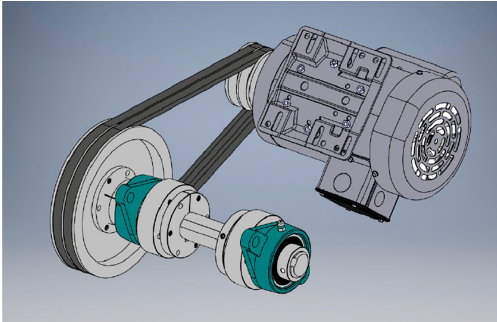
Figure 1. Power transmission system design of the open source waste plastic granulator.